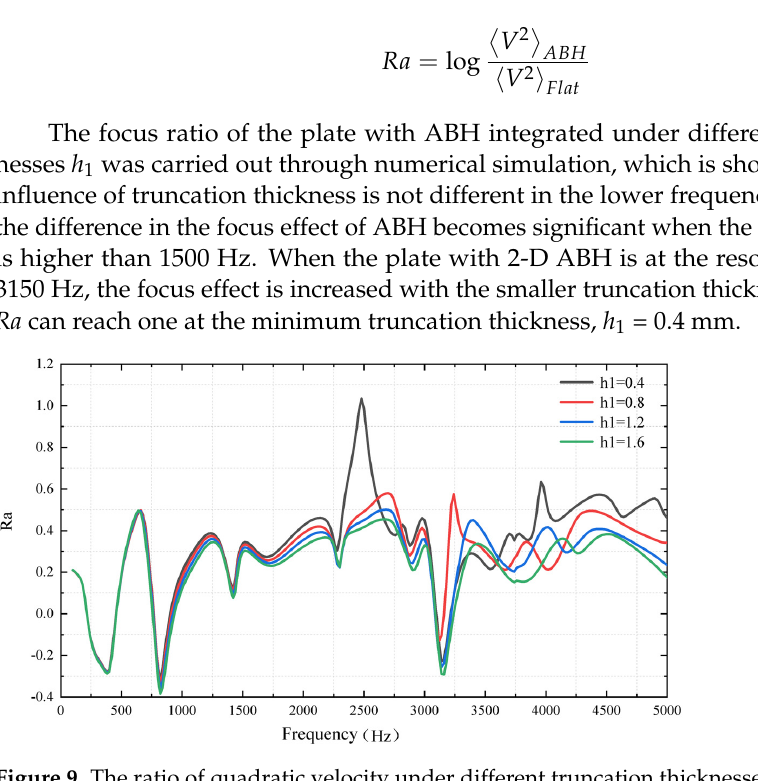
Figure 8. Displacement changes at ABH center point with a different power index.